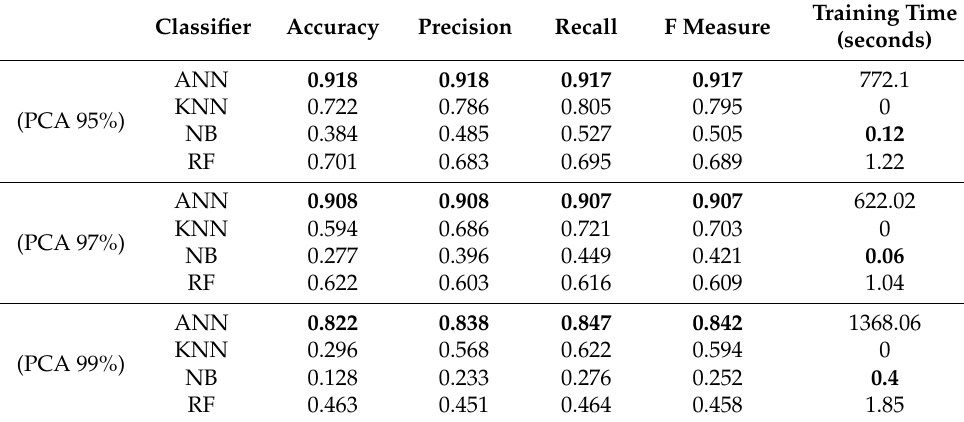
Table 12. Identification results of VGG-19-deep features obtained by averaging (F6 and F7) after applying PCA. Bold values signify the best